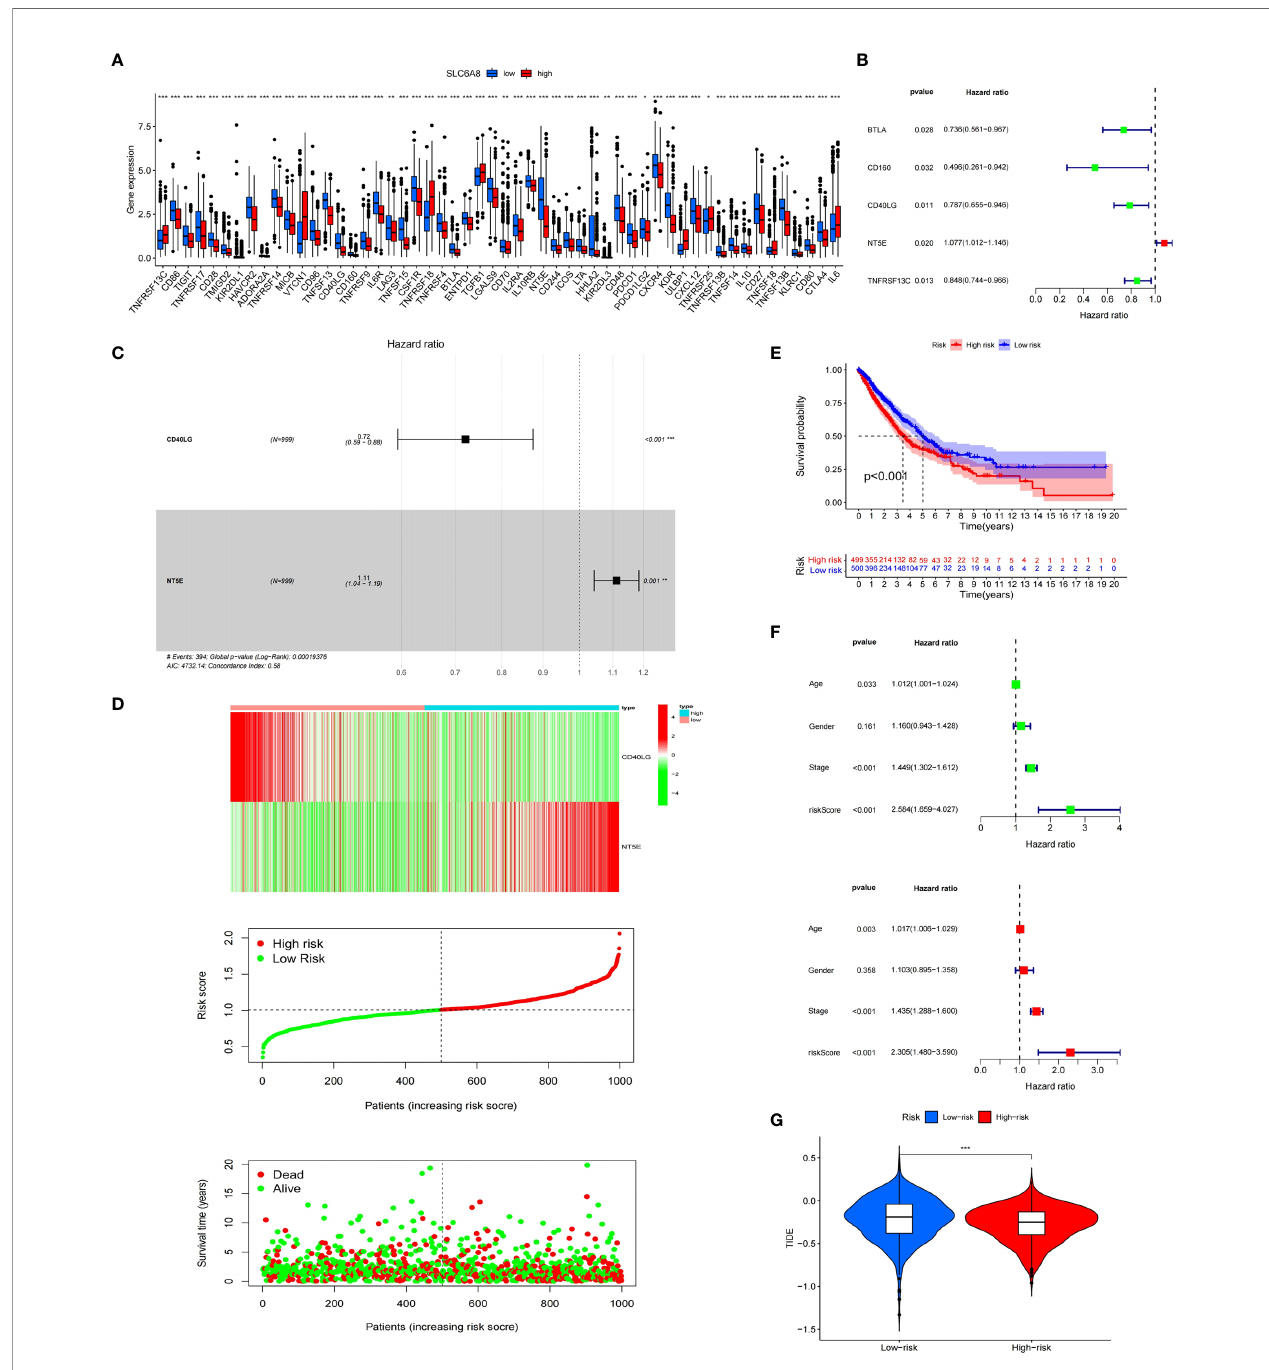
FIGURE 6 | Immunological correlation analysis of SLC6A8 in NSCLC (A) Differential analysis of immunomodulators between high and low SLC6A8 expression groups in NSCLC (B) Prognostic analysis of immunomodulators associated with SLC6A8 in NSCLC (C, D) SLC6A8 -related immune prognostic risk model in NSCLC (E) Prognostic differences between high and low risk groups in the risk model (F) . Model risk scoring combined with clinical factors for univariate and multivariate COX analysis (G) . Comparison of immunotherapy effects between high and low risk groups of the risk model. (*P-value < 0.05; **P-value < 0.01, ***Pvalue <